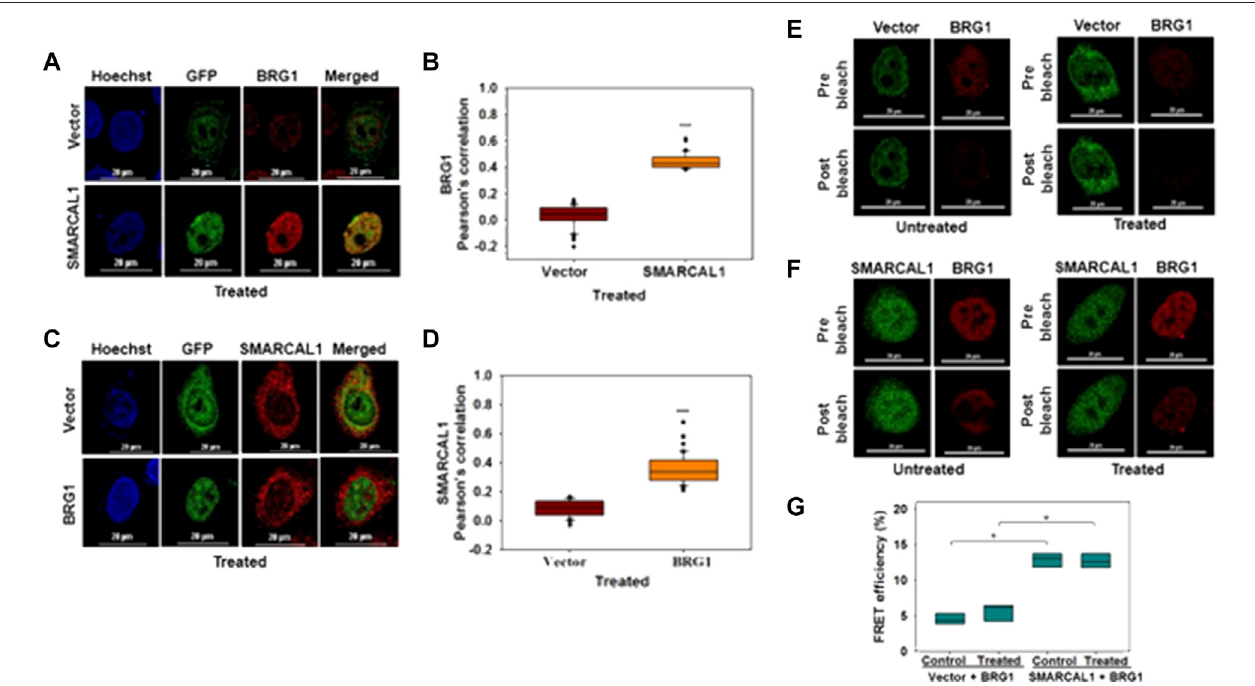
FIGURE2| SMARCAL1andBRG1interactwitheachotherbothintheabsenceandpresenceofDNAdamage (A) .Co-localizationbetweenGFP-SMARCAL1and endogenous BRG1 was monitored in the presence of doxorubicin-induced DNA damage in HeLa cells (B) . Pearson ’ s coef fi cient for the co-localization of GFP SMARCAL1withBRG1 (C) .Co-localization betweenGFP-BRG1and endogenousSMARCAL1wasmonitored inthepresenceofdoxorubicin-inducedDNAdamagein HeLa cells (D) . Pearson ’ s coef fi cient the interaction of GFP-BRG1 with SMARCAL1 (E) . Acceptor Photobleach FRET of GFP-vector alone signal after bleaching endogenous BRG1 in the absence and presence of doxorubicin treatment (F) . Acceptor photobleach FRET of GFP-SMARCAL1 signal after bleaching endogenous BRG1 in the absence and presence of doxorubicin treatment (G) . Quantitation of the FRET ef fi ciency for the interaction of GFP-SMARCAL1 with BRG1. In all the co- localizationexperiments, HeLacells weretreatedwith 2 μ M doxorubicin for10 min and n ≥ 90cellsfor GFP-SMARCAL1and BRG1and n ≥ 40cells forGFP-BRG1 and SMARCAL1 were analyzed. In the FRET experiments, n ≥ 8 cells were analyzed and 2 μ M doxorubicin treatment was given for 10 min. Star indicates signi fi cance with * p -value < 0.05, ** p -value < 0.005, *** p value < 0.0001. The scale in the images is 20 μ m.